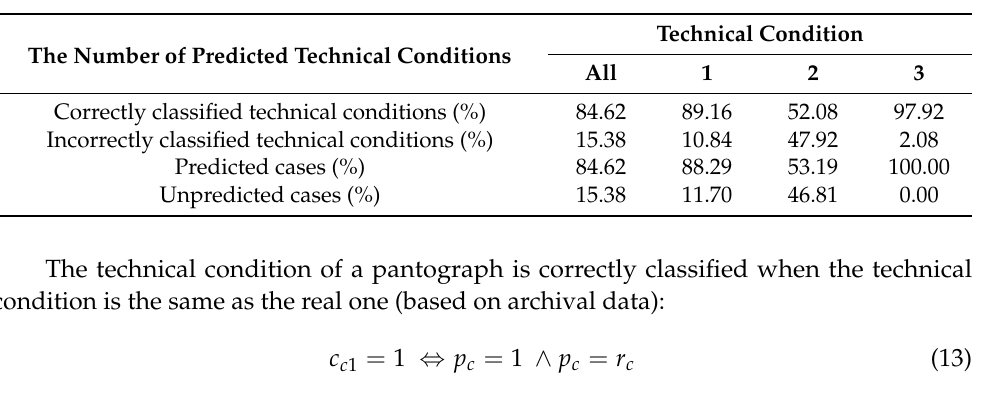
Table 5. Results of a technical condition prediction.